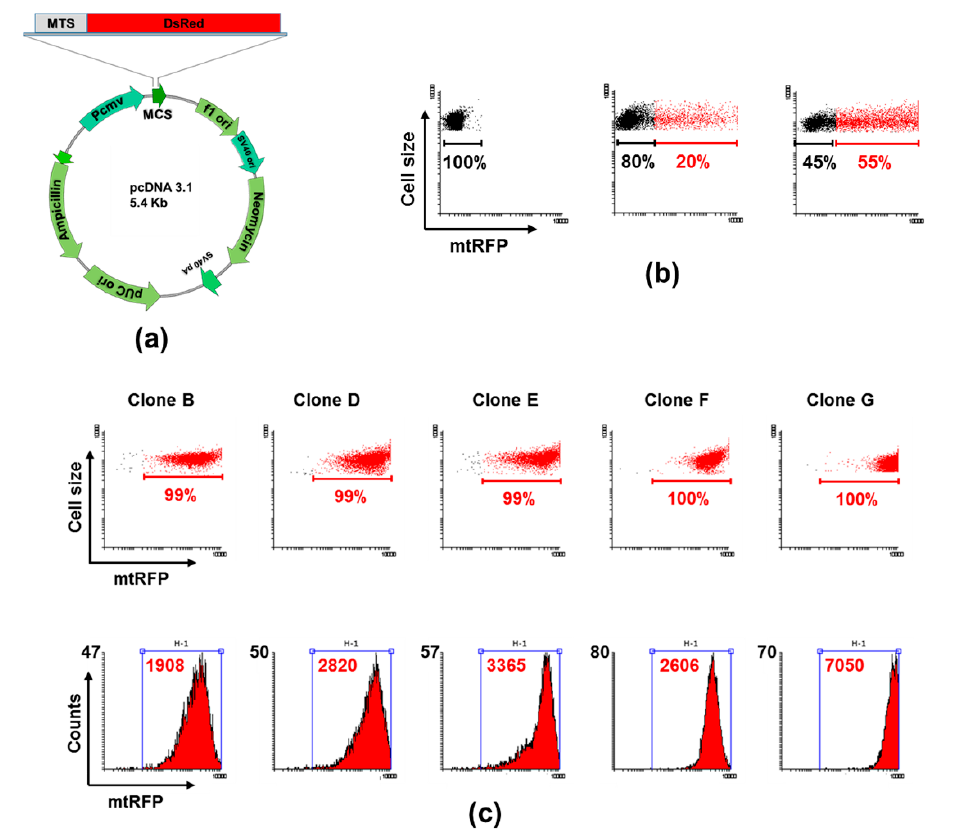
Figure 1. Preparation and isolation of mtRFP clones from 143B cells. ( a ) Scheme of pcDNA3.1 plasmid used to transfect cells, showing the mitochondrial targeting sequence (MTS) of COX VIII attached to a dsRED (RFP) sequence. ( b ) Representative dot plot graphs, obtained by flow cytometry, displaying the mtRFP fluorescence intensity of untreated (left panel), 24 h (middle panel) and 48 h (right panel) transfected cells. The percentage of mtRFP-positive cells is indicated in red. ( c ) Analysis of single clones prepared by limiting dilution. Top panel: dot plot analysis showing percent of mtRFP-positive cells (red). Bottom panel: histogram representation of the dot plots analysis showing the cell fluorescence distribution; the mean fluorescence intensity of H1-gated population is indicated in red.